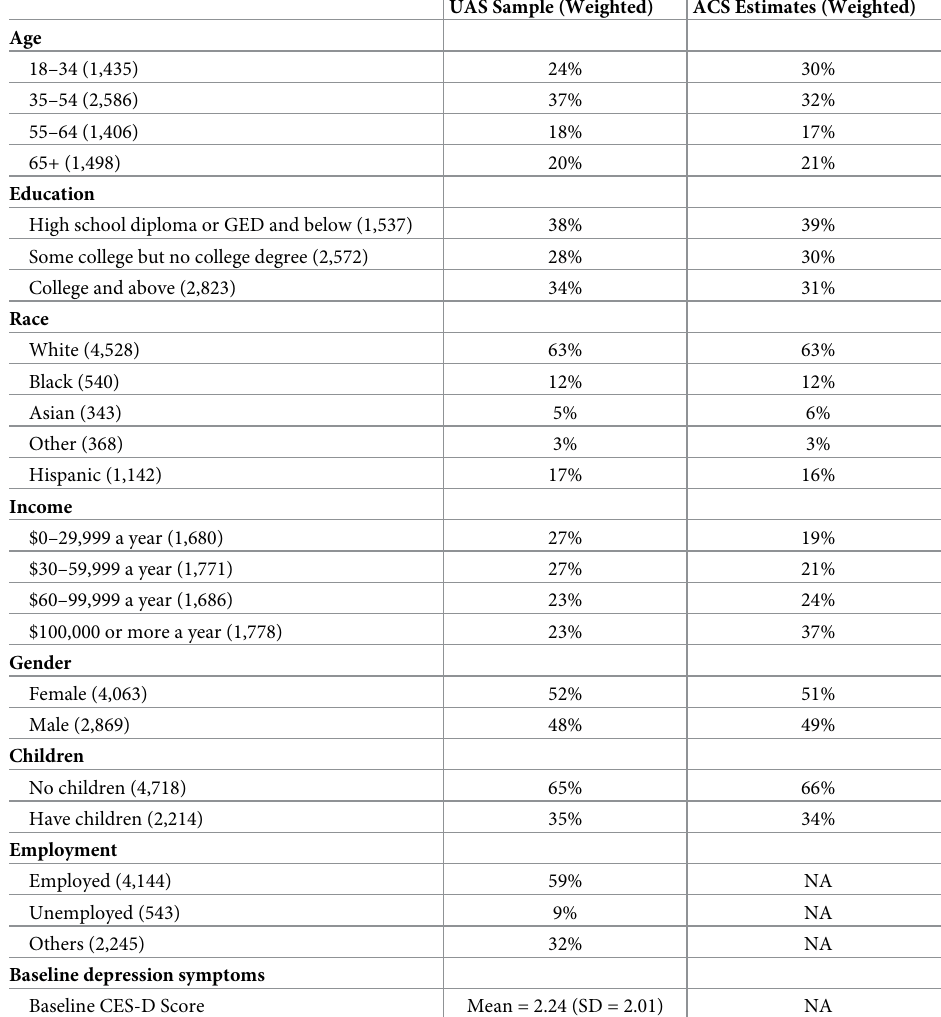
Table 1. UAS COVID sample demographic composition (N = 6,932) vs ACS